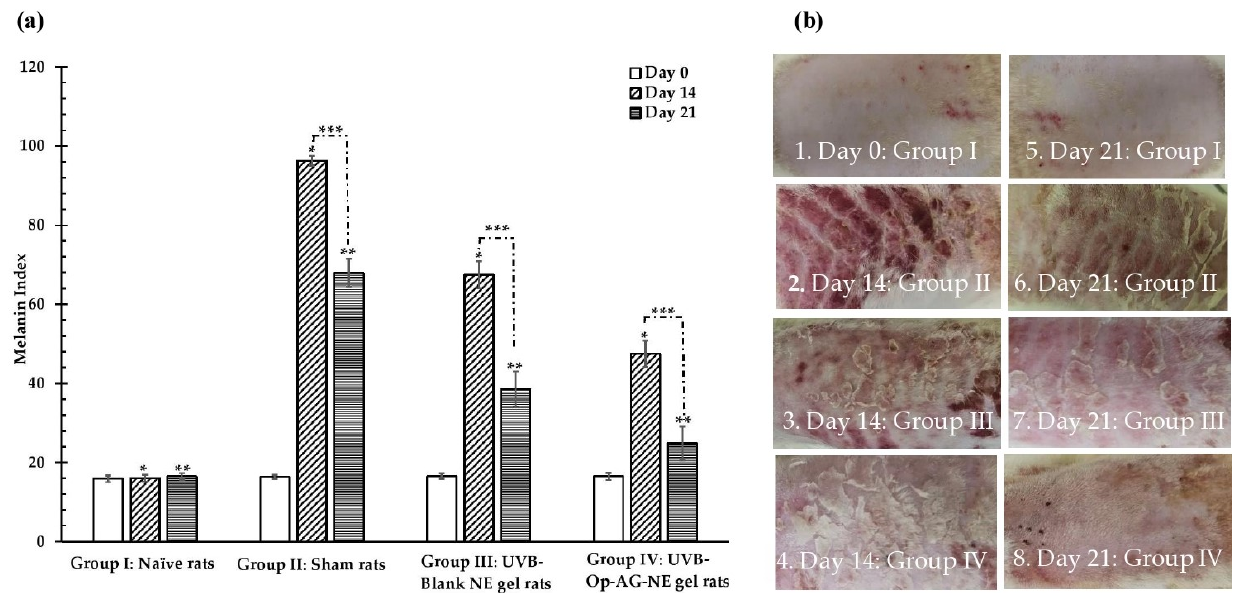
Figure 8. ( a ) Melanin Index (mean ± SD, n = 10) and ( b ) macroscopic skin appearance of the UVB-exposed rats’ skin (*, ** and *** were significantly different at a p -value < 0.05).